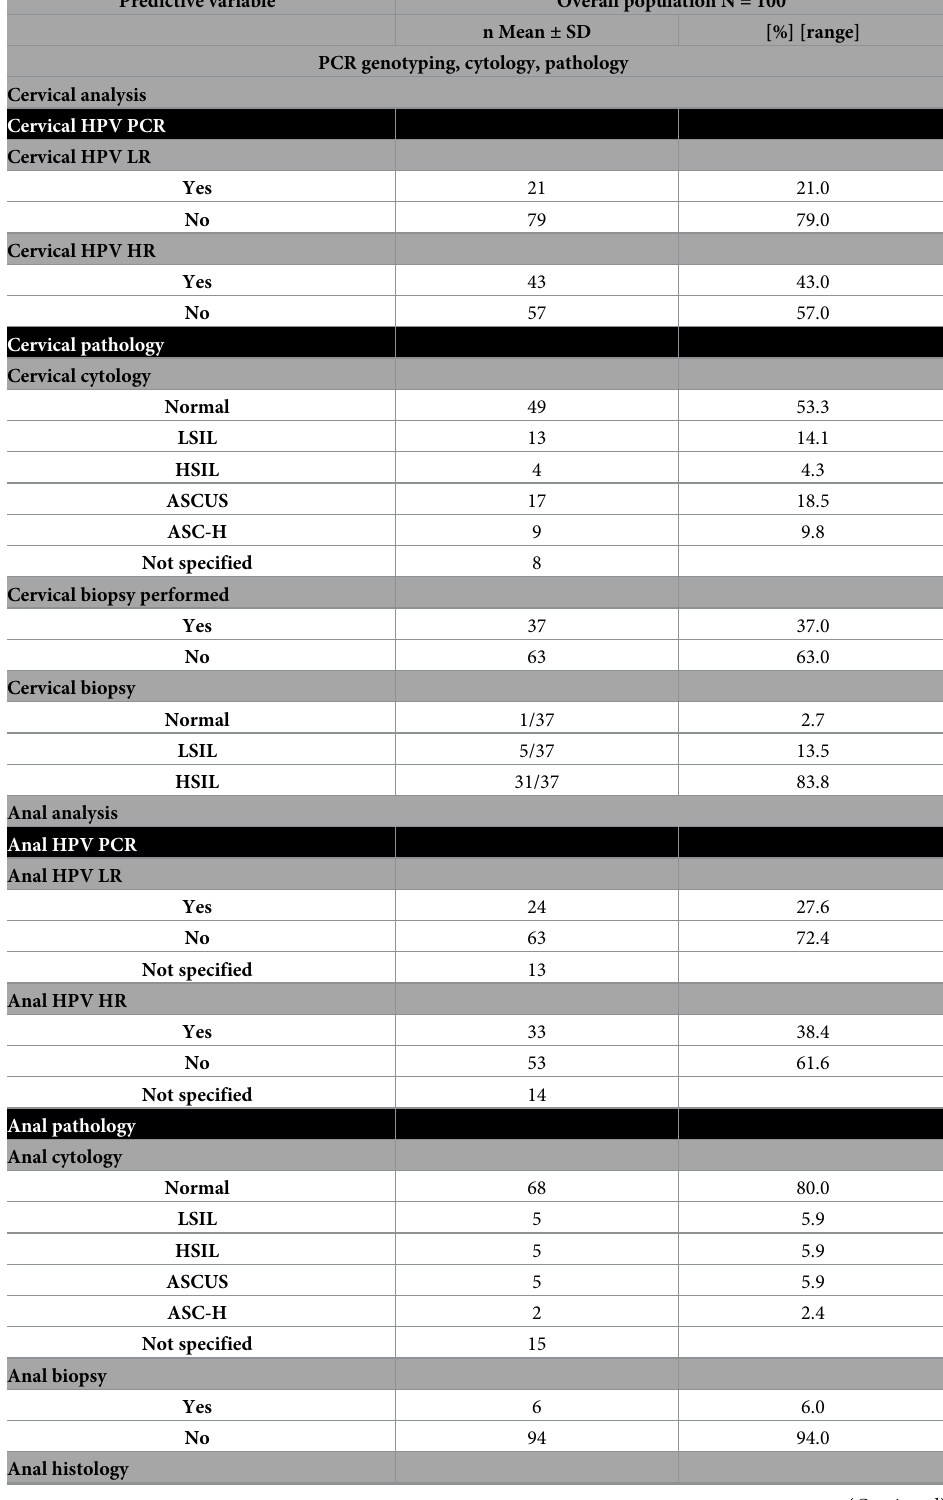
Table 2. Overall population: PCR genotyping, cytology, pathology. A) Cervical analysis B) Anal